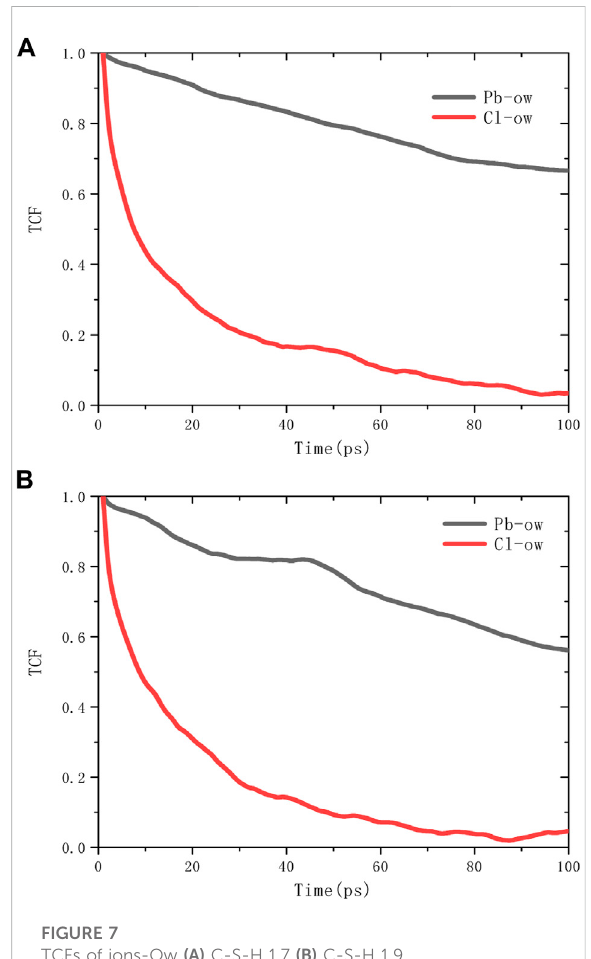
FIGURE 6 RDFsofionsandoxygeninwatermolecules: (A) C-S-H1.7 (B) C-S-H